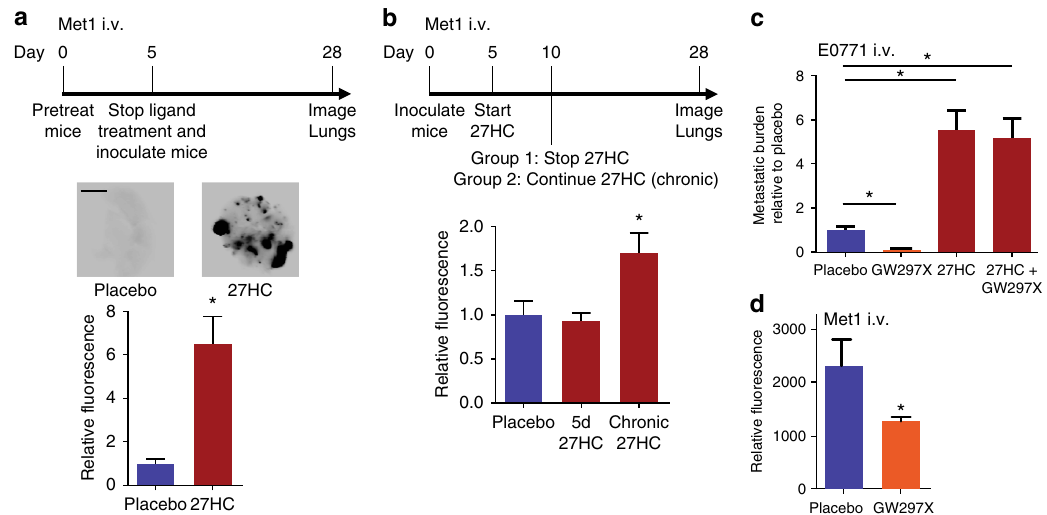
Fig. 2 Effects of 27HC are mediated by its cancer-cell extrinsic effects on the host. a Mice were pretreated with placebo or 27HC (20 mg/kg) daily for 5 days, at which point Met1 cells expressing iRFP were grafted (i.v.) and treatment ceased. At day 28, lungs were harvested, imaged and iRFP fl uorescence quanti fi ed. Experimental timeline outlined above. Representative images of iRFP-expressing Met1 colonies (depicted as black ) within the lungs are presented above quanti fi ed data (placebo N = 5, 27HC N = 4, scale bar indicates 5 mm). b Mice were grafted (i.v.) with Met1 cells expressing iRFP on day